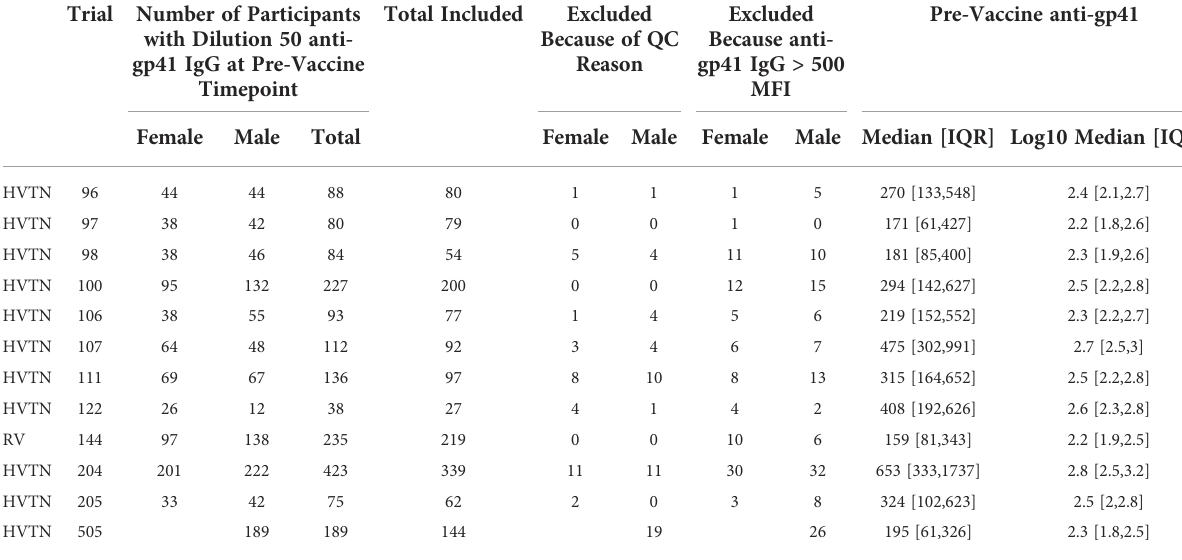
TABLE 1 Number of participant with pre- and post-vaccine gp41 BAMA measurements meeting QC requirements. Trial Number of